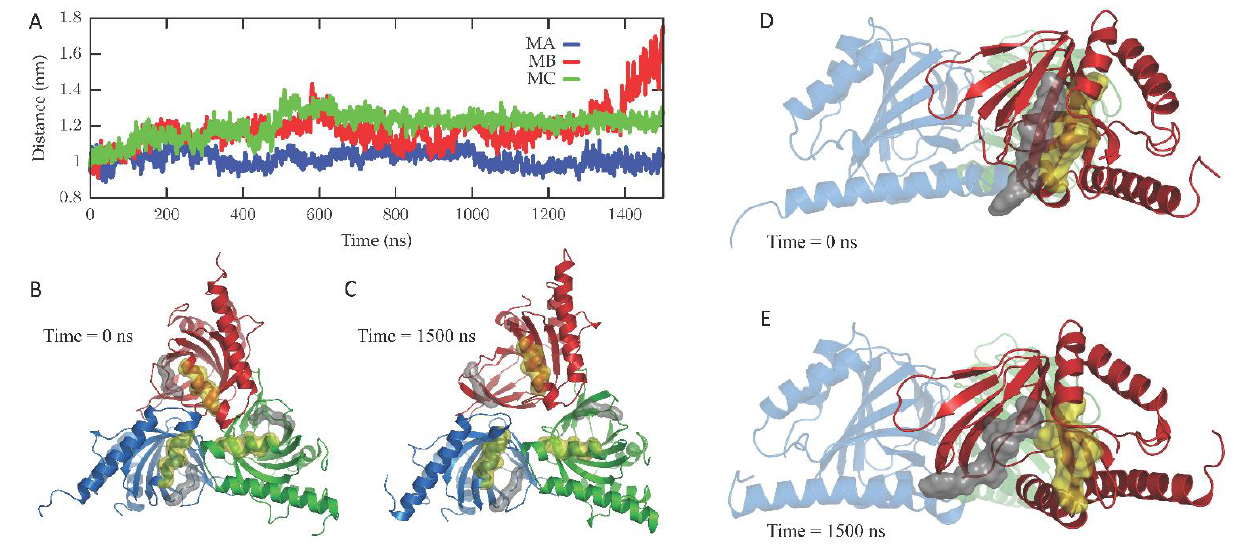
Figure 2. Conformational changes occurring in the Hs σ 1-R protein along the simulated trajectory. ( A ) The distances between the mass centers of the backbone atoms of residues 118–121 and 180–188 for the three monomers (namely, MA, MB and MC) are reported as a function of time. ( B , C ) Cartoon representation of the Hs σ 1-R protein viewed from the membrane side at 0 ns ( B ) and 1500 ns ( C ) of the MD simulation. The three monomers are colored blue (M1), red (M2) and green (M3). The surface of residues 118–121 and 180–188 of the three monomers is also shown and colored grey and yellow, respectively. ( D , E ) Cartoon representation of the Hs σ 1-R protein C-terminal domains, external to the membrane, at 0 ns ( D ) and 1500 ns ( E ) of the MD simulation. The surface of residues 122–126 and 171–176 of M2 (red) is also shown and colored grey and yellow, respectively, highlighting the opening of the Hs σ 1-R binding site that occurs along the simulated trajectory.